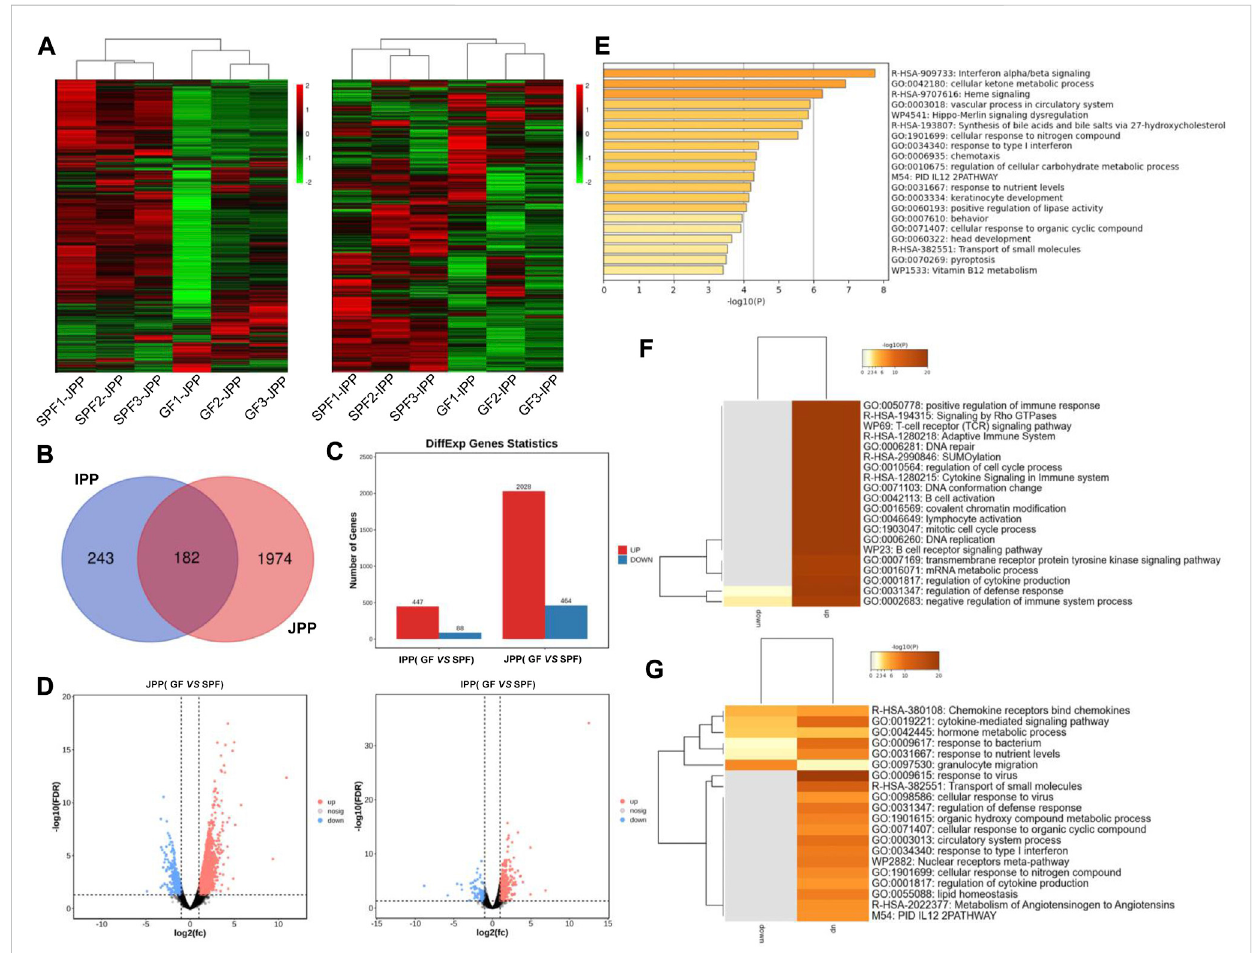
FIGURE 4 mRNA expression pro fi les of intestinal PPs in SPF and GF piglets. (A) Hierarchical clustering based on global expression pro fi les of mRNAs in IPPs or JPPs. (B) Thenumberofsharedandspeci fi cDEmRNAsinIPPsandJPPs. (C) ThenumberofupregulatedanddownregulatedDEmRNAsinJPPsandIPPs. (D) TheDEmRNAsinJPPsandIPPswereanalyzedandvisualizedbyvolcanoplotting. (E) FunctionalenrichmentanalysisofsharedDEmRNAsinJPPsand IPPs. Functional enrichment analysis of speci fi c DE mRNAs in JPPs (F) and IPPs (G) . n =